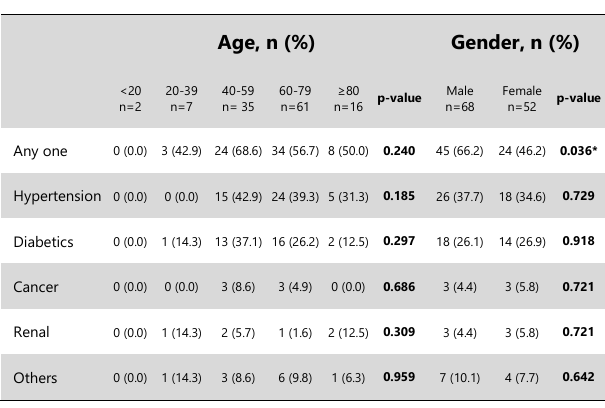
Table . Test of Association Between Age, Gender and